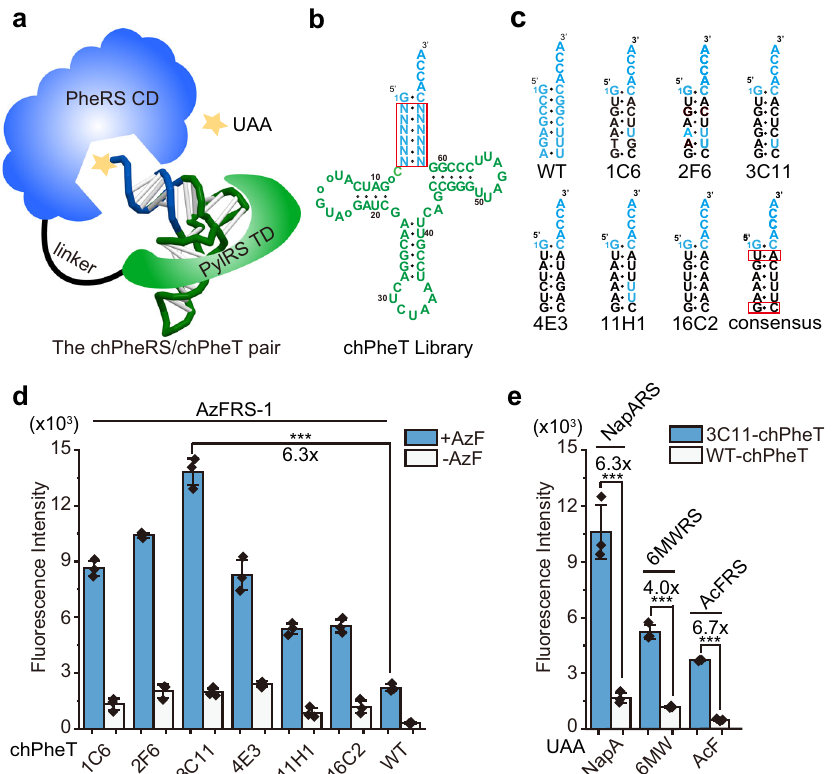
Fig. 2 Evolution of chimeric tRNAs. a The cartoon structure of the chimeric Phe system with components from the pyrrolysine system colored in green and components from the Phe system colored in blue. b The cloverleaf structure of chPheT. The nucleotides in the acceptor stem were randomized and highlighted by the red box. N represents A, T, G, or C. c The acceptor stem of chPheT variants with nucleotides from the WT colored in blue. The consensus chPheT is shown with the common pair-bases in all variants highlighted by red boxes. d Amber suppression ef fi ciency of chPheT variants by the AzFRS-1 is tested by a GFP reporter assay with (blue bars) or without (white bars) the addition of AzF. WT-chPheT is used as the control. e Amber suppression ef fi ciency of various chPheRSs with 3C11-chPheT (blue bars) or WT-chPheT (white bars) in the presence of 1 mM of indicated UAAs. Error bars represents ±standard error of the mean from three biologically independent experiments. Statistical signi fi cance is quanti fi ed with one-way ANOVA (*** p < 0.001). Source data are provided as a Source Data fi (Fig. 2d). Additionally, 3C11-chPheT was paired with various